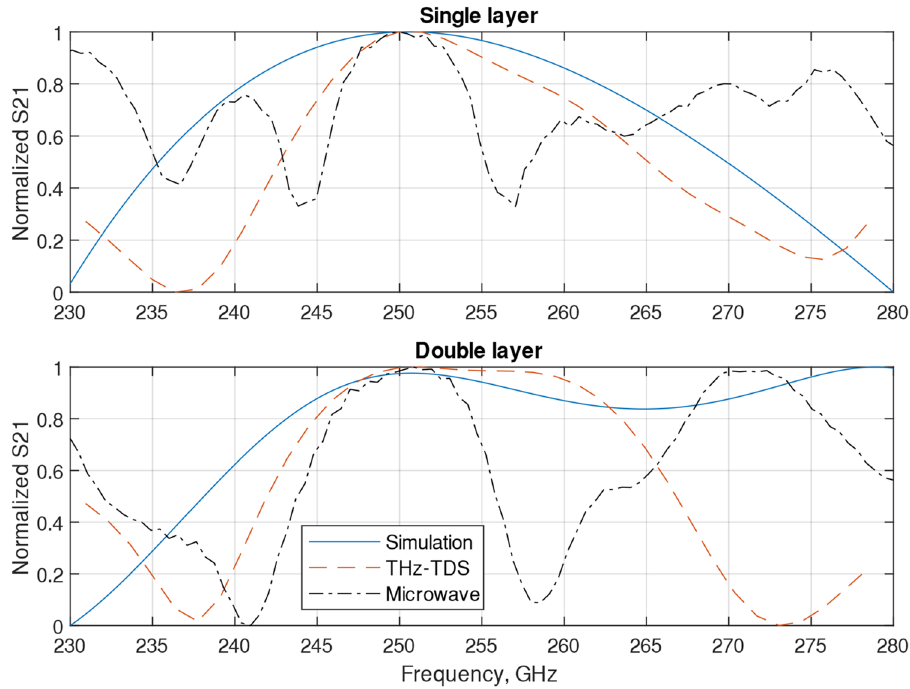
Figure 9. Comparison of the simulation, THz-TDS, and microwave normalized